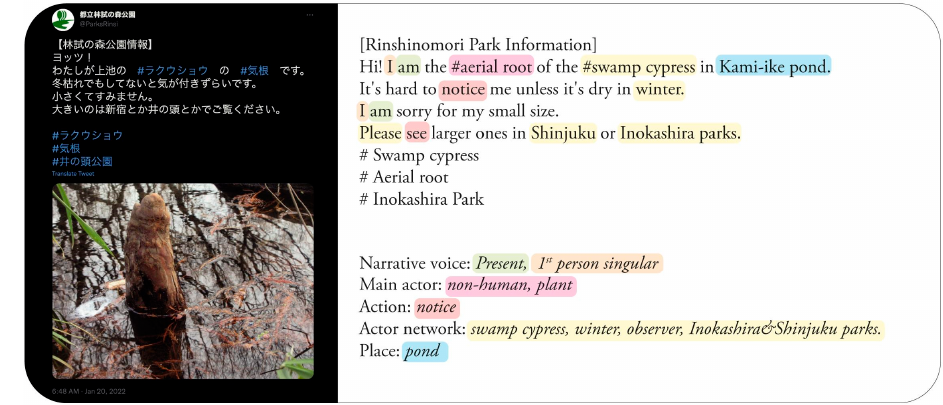
Figure 2. Analysis example. Original tweet in Japanese, English translation and categories.